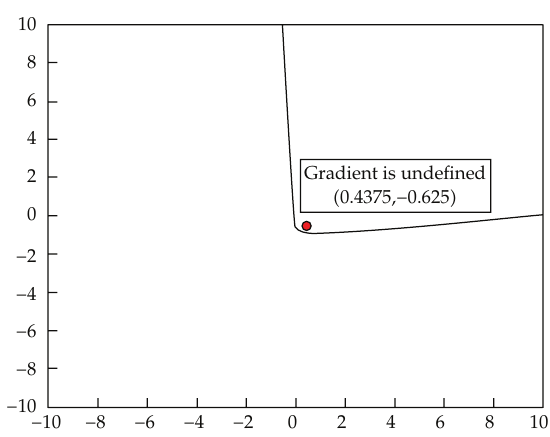
Figure 3: The gradient for cone (cid:2) 1 (cid:3) of Example 2.1 is undefined at the indicated